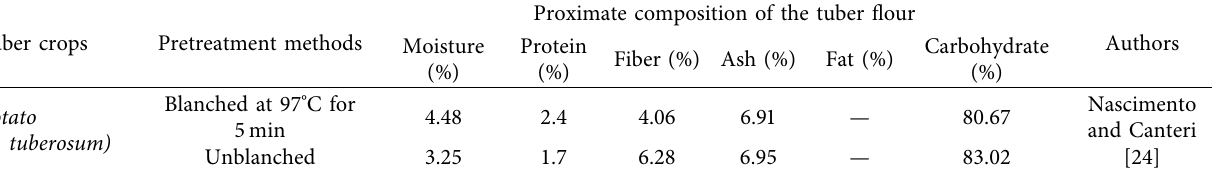
Table 2: Review on the effects of pretreatments on the proximate composition of tuber crop. Proximate composition of the tuber Tuber crops Pretreatment methods